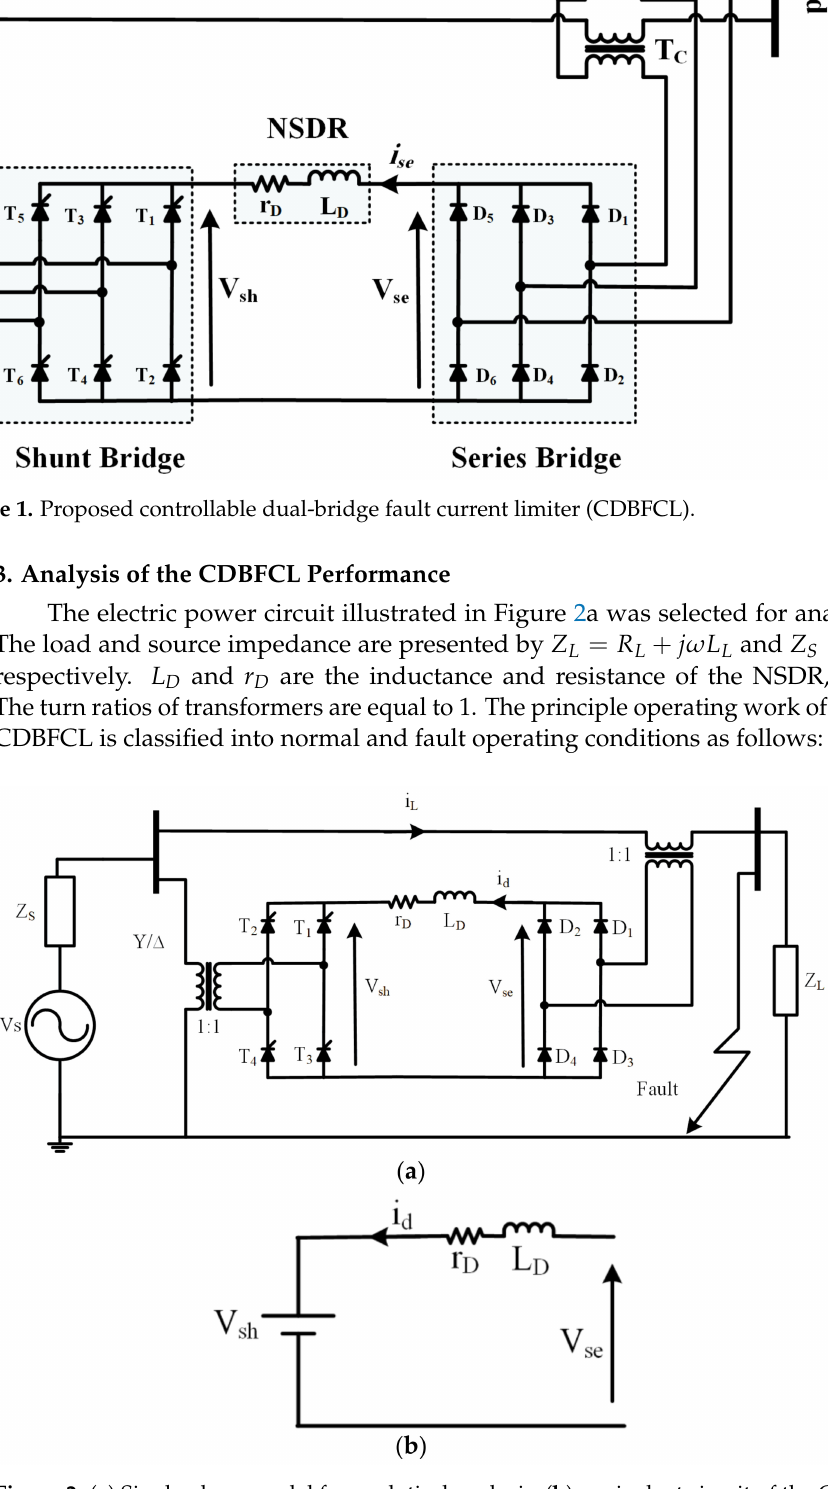
Figure 2. ( a ) Single phase model for analytical analysis, ( b ) equivalent circuit of the CDBFCL on the DC